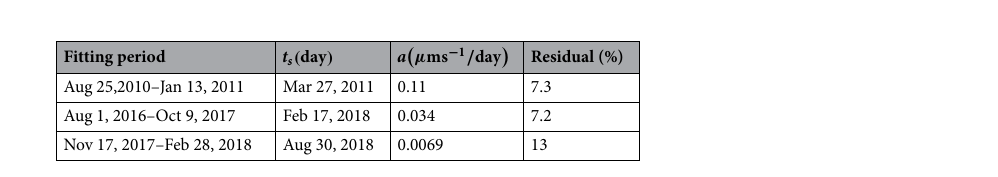
Table 1. Parameters for fitting the SBL growth prior to eruptions by